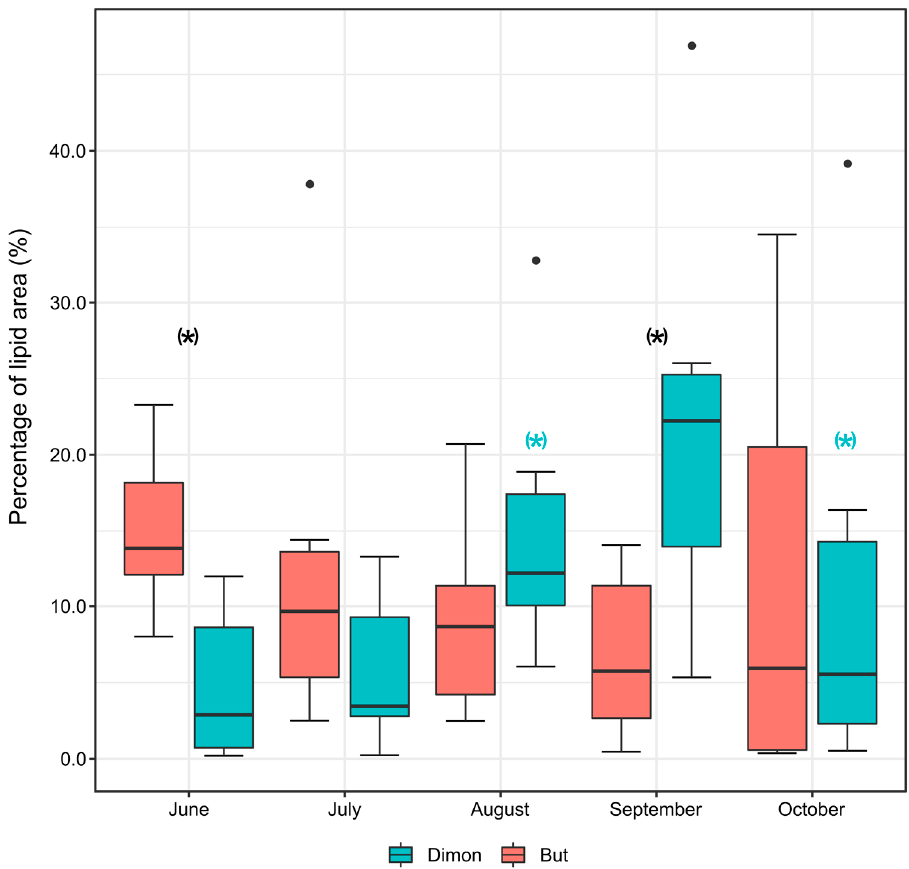
Figure 6. Trends in liver lipid area percentage in the C. gobio from Dimon Lake and But Stream ( n = 6 per month at both sites, including three males and three females). Blue asterisks (* = p -level < 0.05) indicate significant di ff erences in Dimon Lake with the previous monthly value. Black asterisks (* = p -level < 0.05) indicate significant differences between But and Dimon monthly values.)